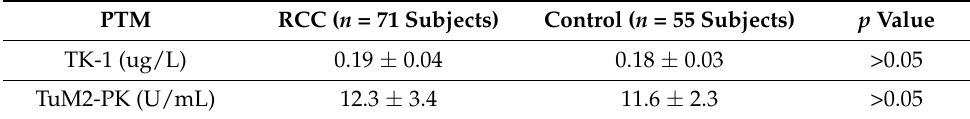
Table 6. TK-1 and TuM2-PK status in the studied